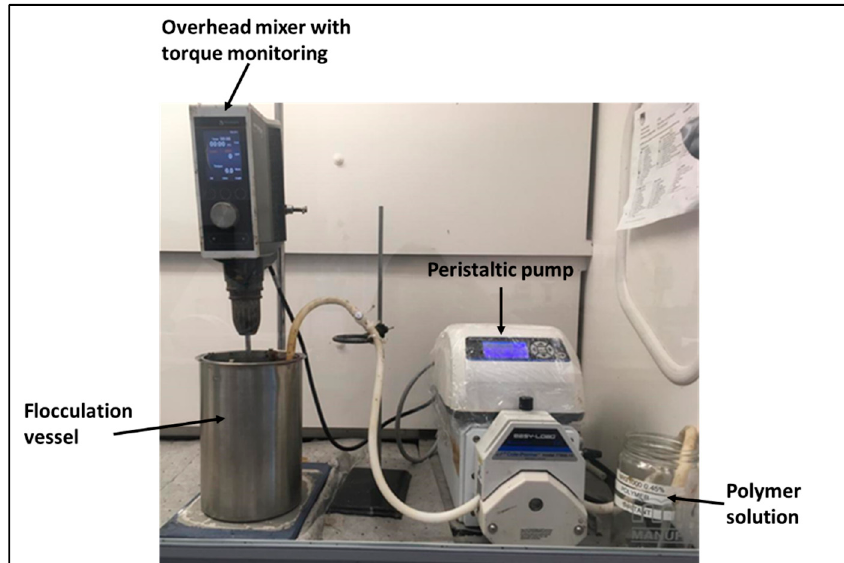
Figure 1. Flocculation setup.